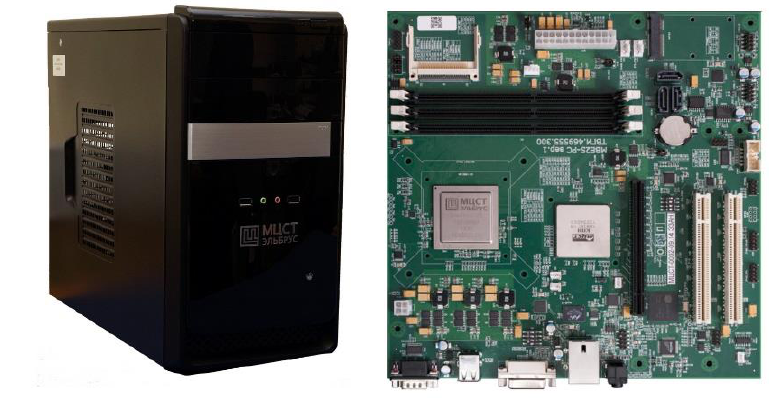
Fig. 4. «Elbrus 401 - РС» workstation [17].